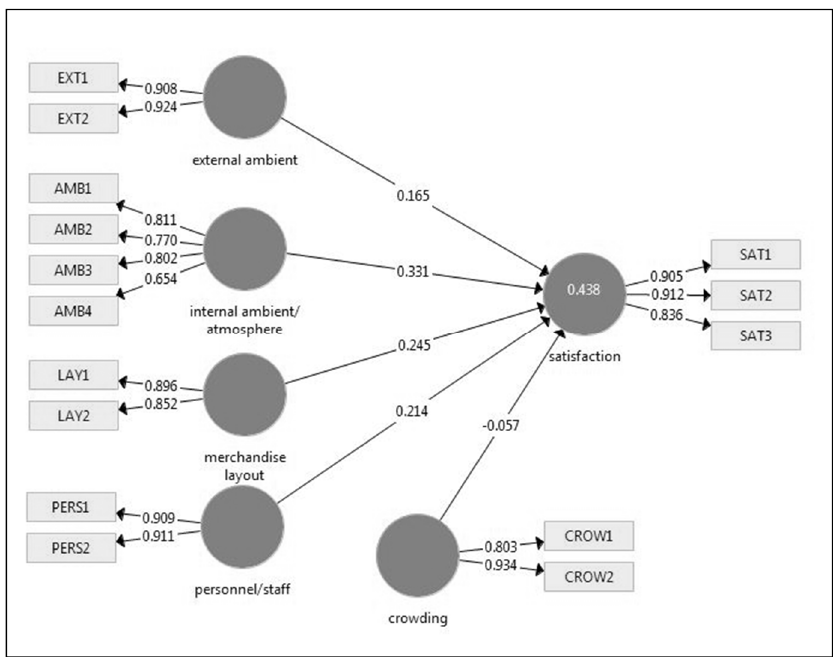
Figure 2. Results of the path analysis (Hedonic shopping).